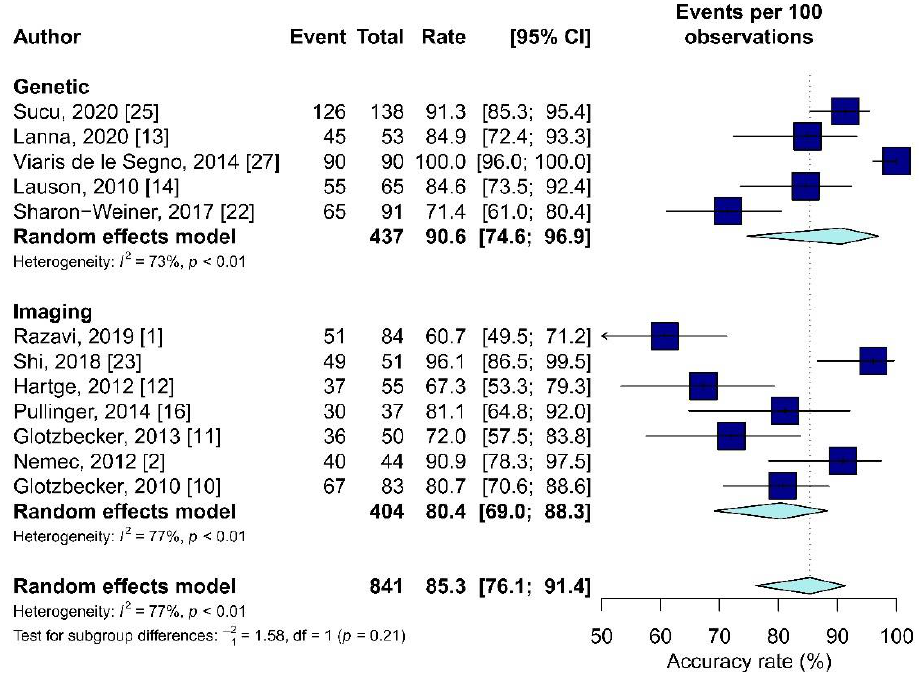
Figure 3. The forest plot of the accuracy rate in the “Genetic” and “Imaging” groups.